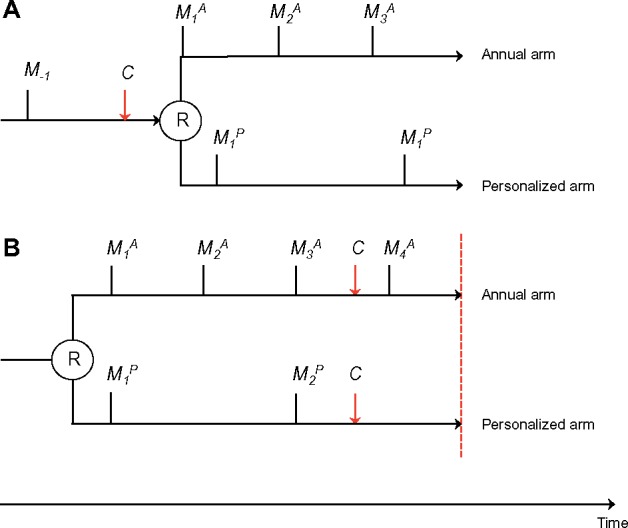
An example woman of average risk is randomly assigned to either the annual arm or to the personalized arm. Black vertical lines indicate mammograms (M). R denotes randomization (study entry). Red dashed line indicates end-of-study. Red arrows indicate development of stage IIB or higher breast cancer.